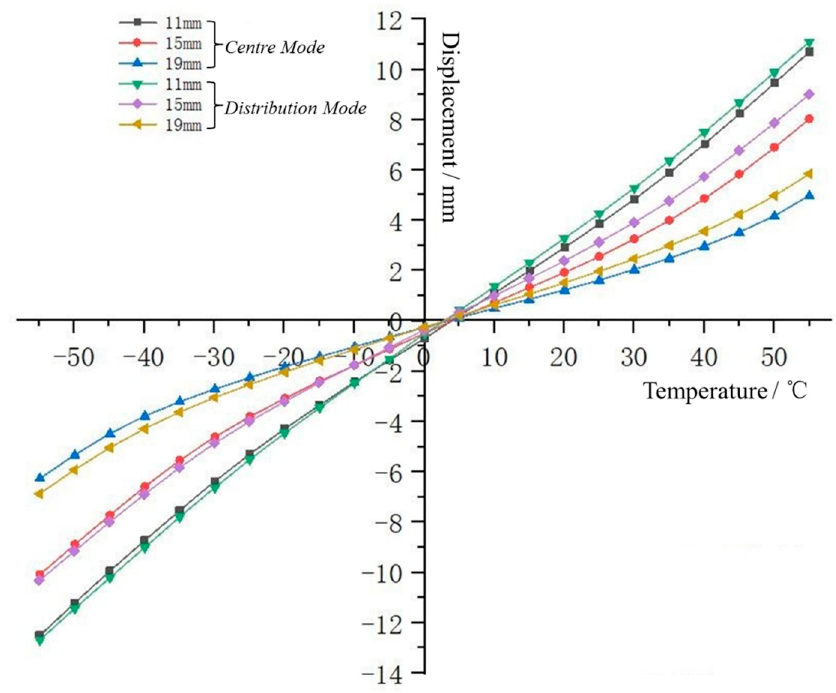
Figure 6. Displacement–temperature curve of bellows with different wall thicknesses.